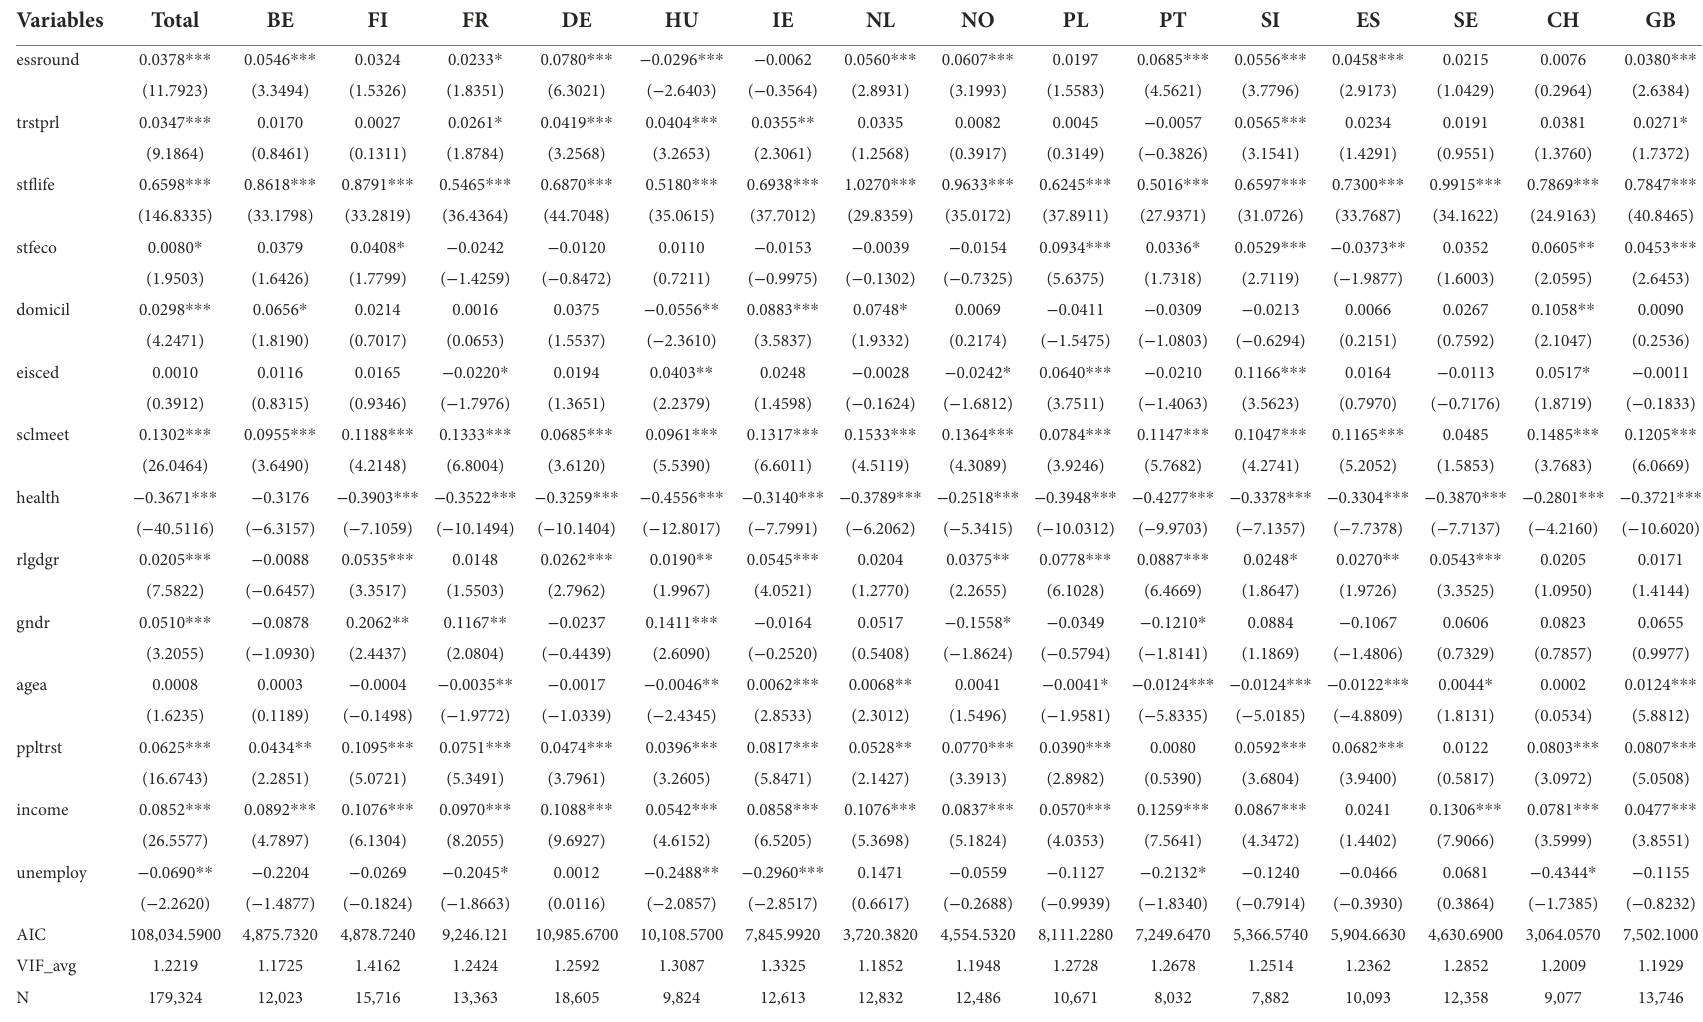
TABLE 2 The comparison of happiness determinants across nations in native group.